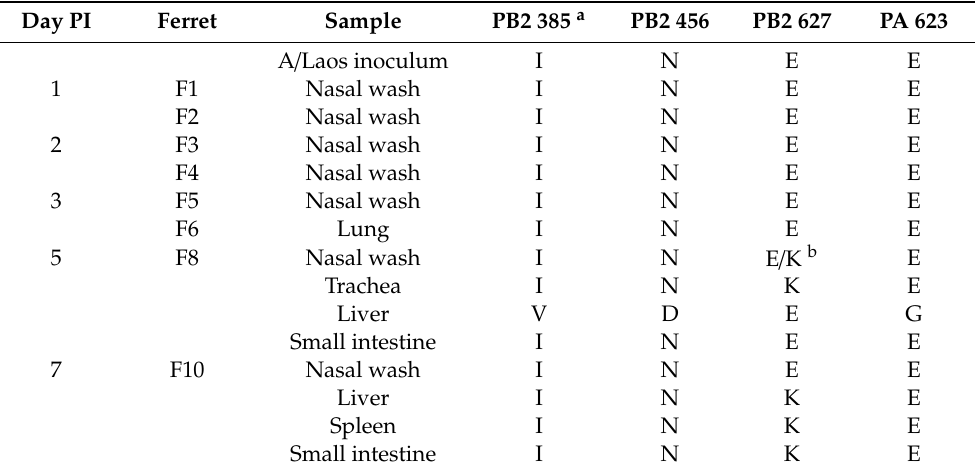
Table 3. A / Laos AA sequence changes in tissues and nasal